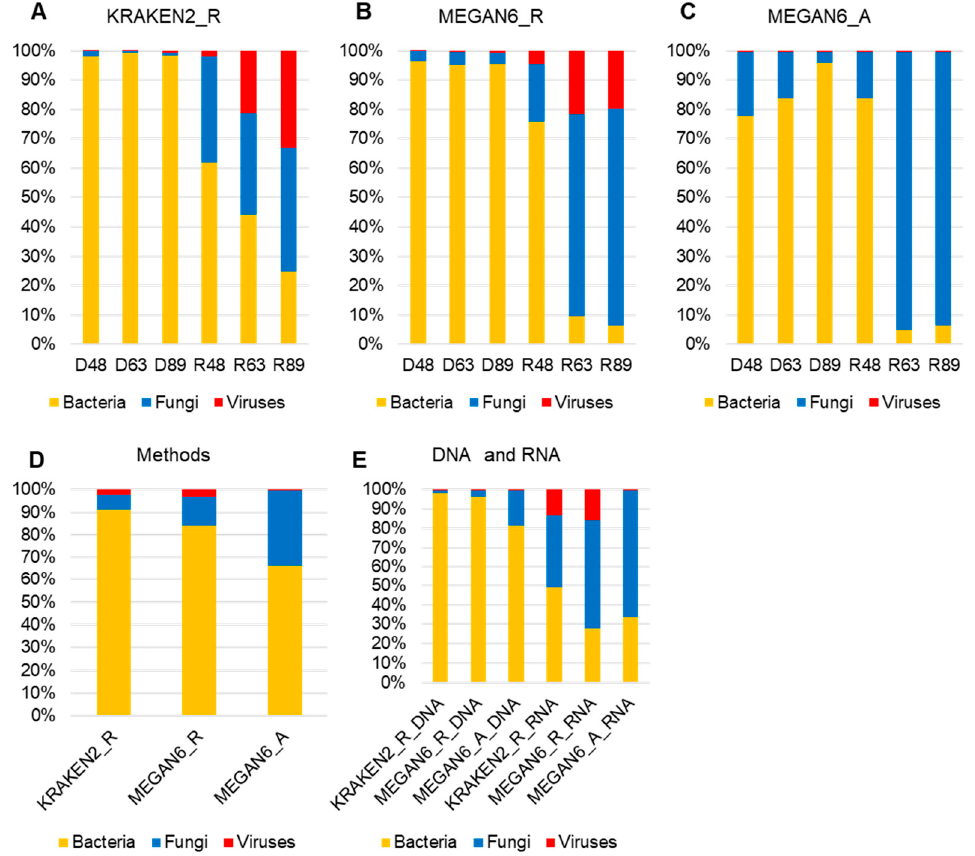
Figure 6. Proportion of three different microbial groups (i.e., bacteria, fungi, and viruses) in each library identified using KRAKEN2_R ( A ), MEGAN6_R ( B ), and MEGAN6_A ( C ). Comparison of identified microbial groups by different methods ( D ) and library types (i.e., DNA and RNA) ( E ).